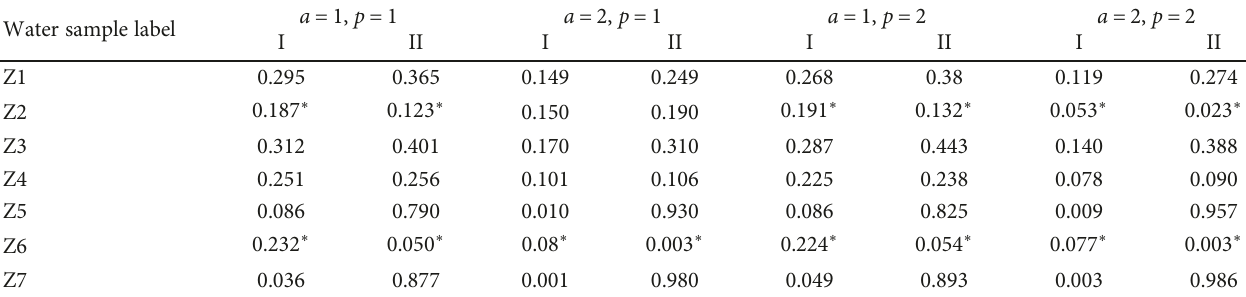
Table 6: Recognition results under di ff erent parameters.